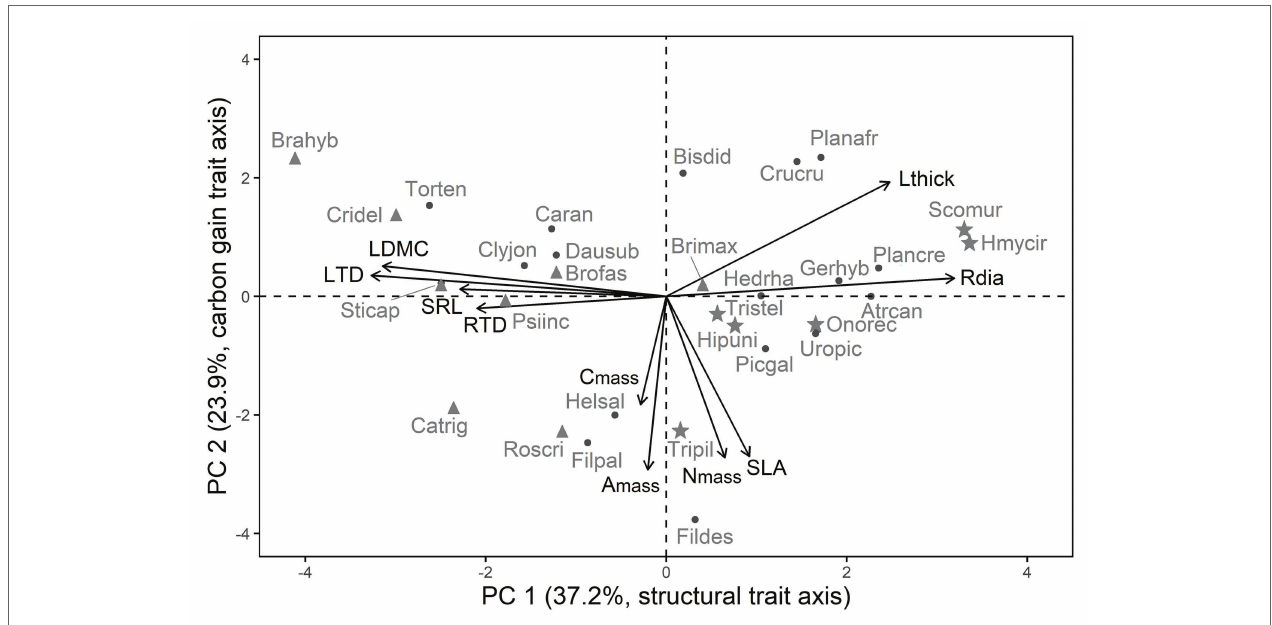
FIGURE 1 | Resource-use related traits are correlated along two axes in 30 winter annual species, the first axis corresponds to structural traits (PC 1), and the second to carbon gain traits (PC 2). Trait abbreviations and trait loadings are given in Tables 1 , 2 , and species abbreviations are given in Supplementary Table S1 , respectively. Symbols indicate life form: triangles for grasses, points for non-legume forbs, asterisks for legumes. Grasses differed from non-legume forbs and legumes in their species’ scores along PC 1, but not along PC